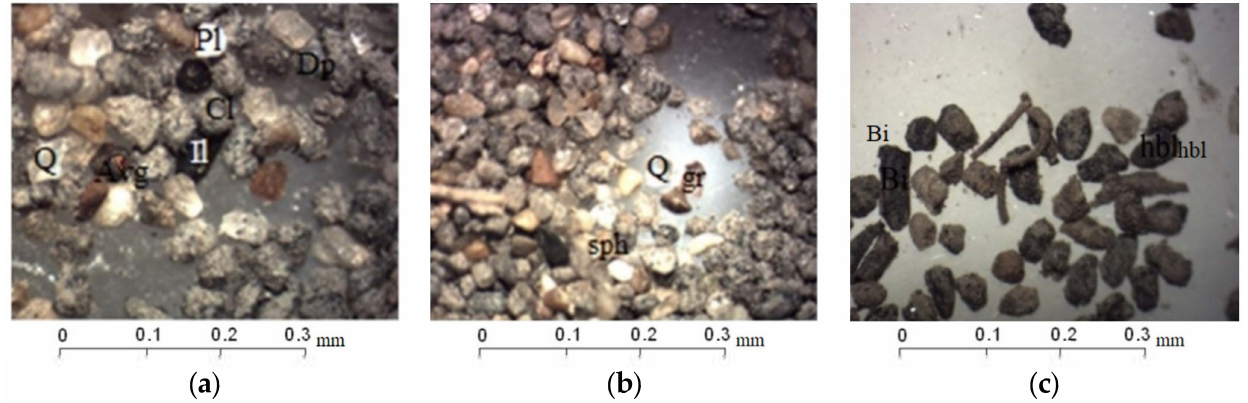
Figure 3. Mineral composition of sand fraction studied with a binocular microscope: ( a ) Grains of quartz (Q), plagioclase (PI), chlorite (Cl), pyroxenes (Dp), amphiboles (Avg), ilmenite (I1) (Sample «11»); ( b ) grains of quartz (Q), sphene (sph), garnet (gr), and ferrous fragments of rocks (Sample «11»); ( c ) chitinous debris from insects, grains of biotite (Bi), clays, and fragments of rocks (Sample «VP1»).